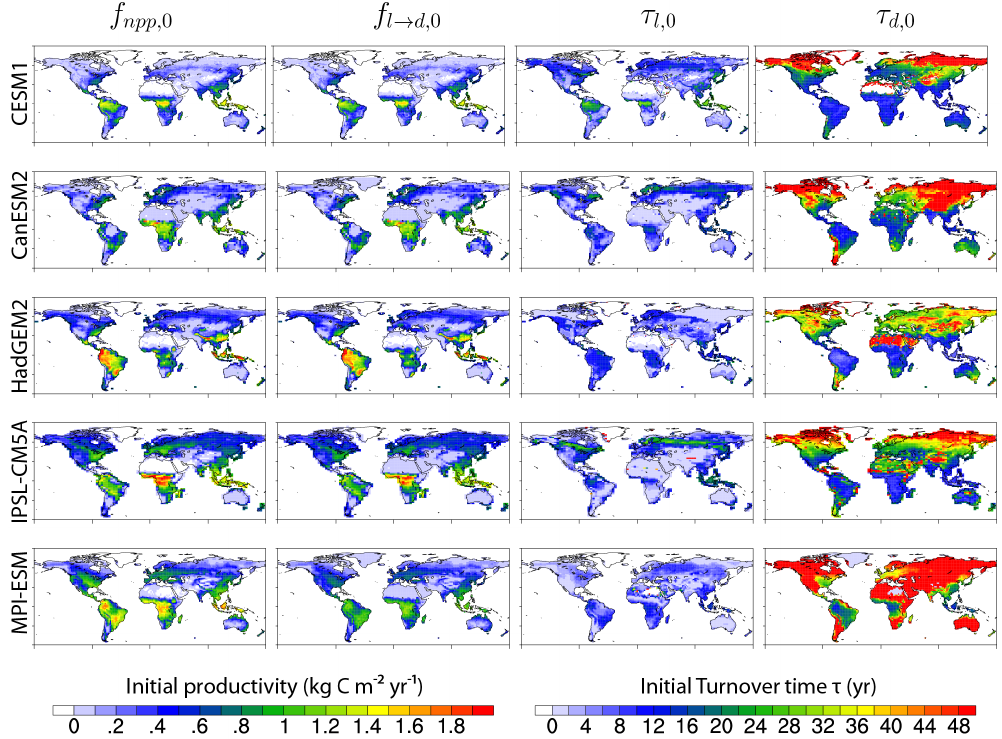
Figure 1. Comparison of initial (preindustrial) productivity (kgCm − 2 yr − 1 ) and turnover times (yr) for both the live and dead carbon pools in the models. Columns, from left to right, show f npp , f l → d, 0 , τ l, 0 , and τ d, 0 . Model agreement is generally higher on initial productivity than either of the turnover times, in which models disagree on both the magnitude and fundamental geographic